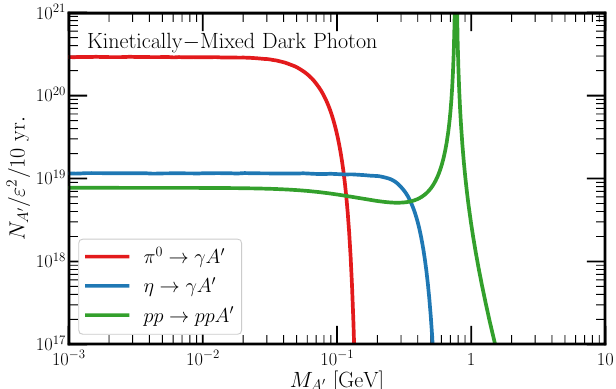
Figure 5 . Expected number of A 0 that travel towards the DUNE Multi-Purpose Near Detector, a distance of 579 m from the production target, as a function of mass M A 0 . We assume ten years of beam operation, " = 1, and a beam luminosity of 1 : 47 displays A 0 produced via decays of (cid:25) 0 , the blue line displays those from (cid:17) decays, and the green displays those produced in the bremsstrahlung process pp